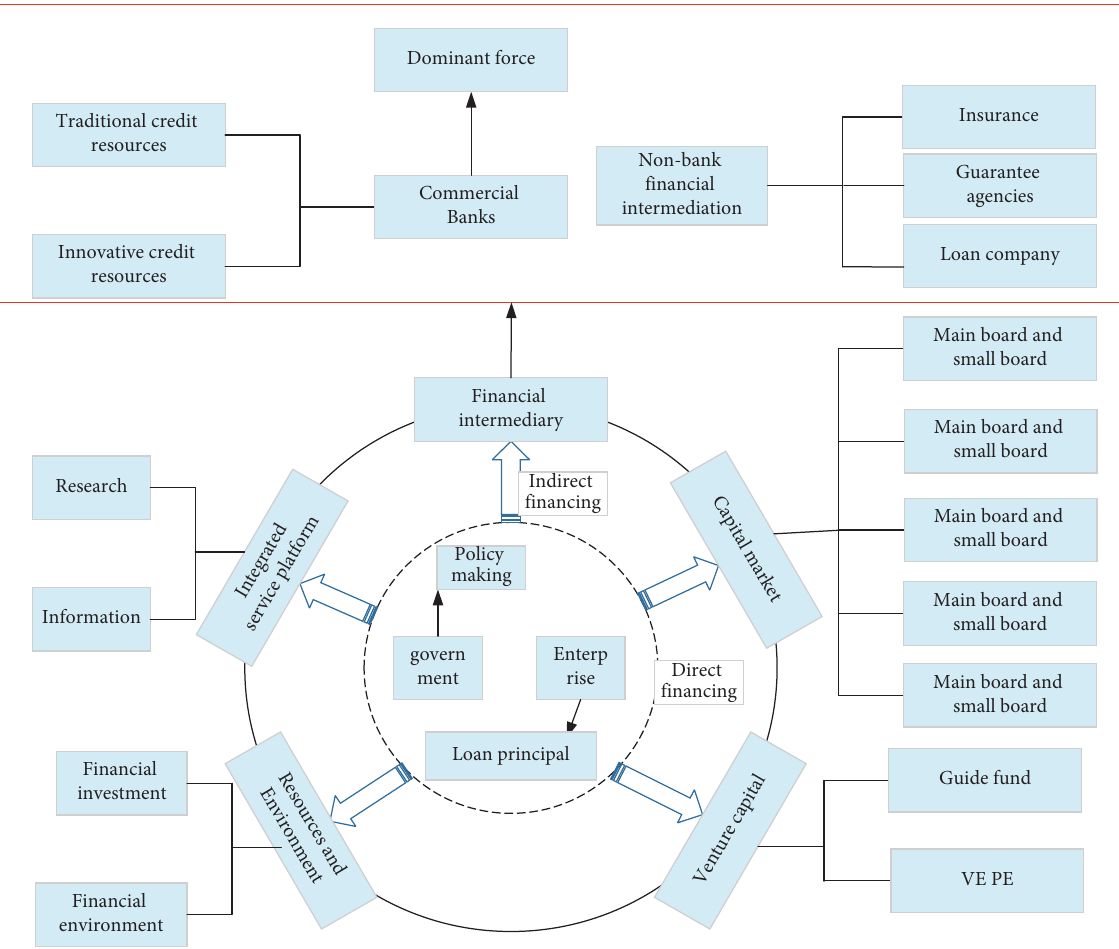
Figure 1: Commercial banks